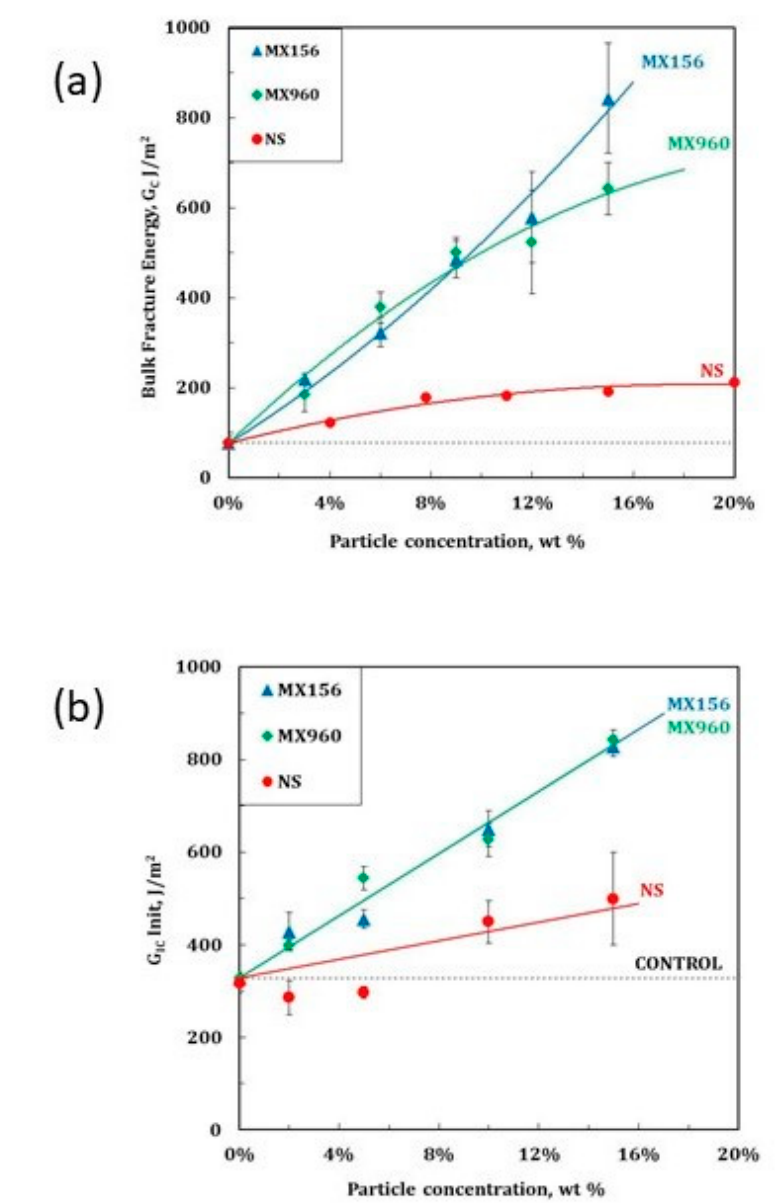
Figure 15. Fracture energy versus particle addition level for bulk ( a ) and glass fiber-reinforced composite ( b ) [63].